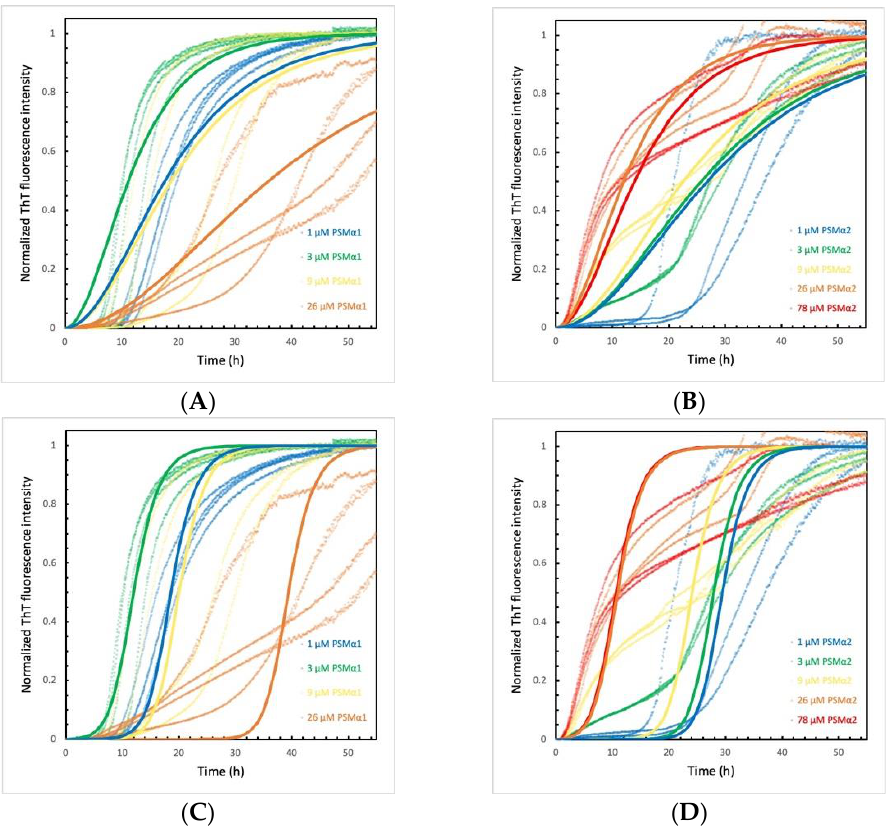
Figure 2. Fitting of models of nucleation and elongation to aggregation kinetics of α -syn in the presence of PSMα peptides. The ThT fluorescence intensities as a function of time of 25 μM α - syn aggregation induced by varying PSMα1 ( A , C ) and PSMα2 ( B , D ) concentrations (µM) were fitted to models of primary nucleation and elongation ( A , B ) or to models of pri- mary nucleation, elongation and secondary nucleation ( C , D ). The dotted lines are the normalized ThT fluorescence inten- sities and the solid lines are the fits as calculated by Amylofit. All experiments started from monomers and were performed in 10 mM Tris, 50 mM NaCl, pH 7.6 at 37 °C under quiescent